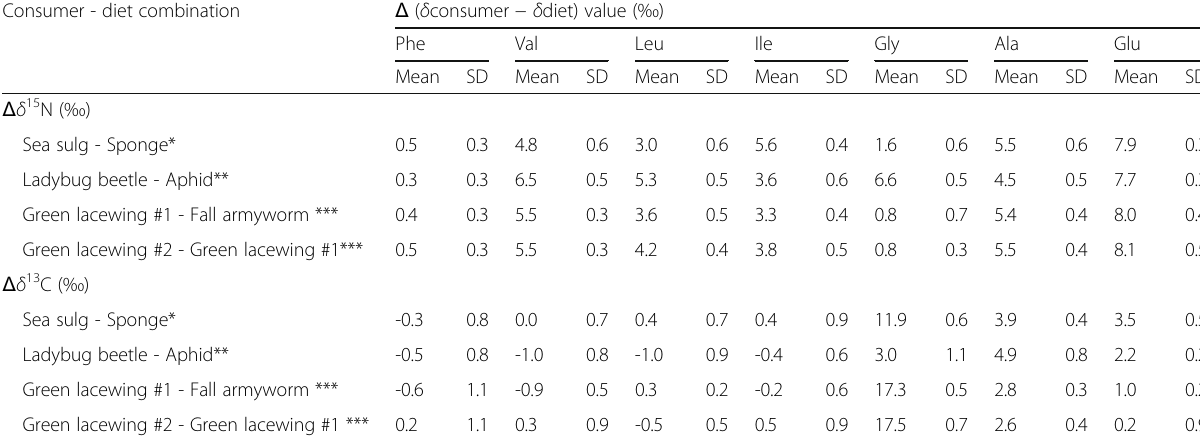
Table 2 Nitrogen and carbon isotopic discriminations on amino acids in the four combination samples Consumer - diet combination